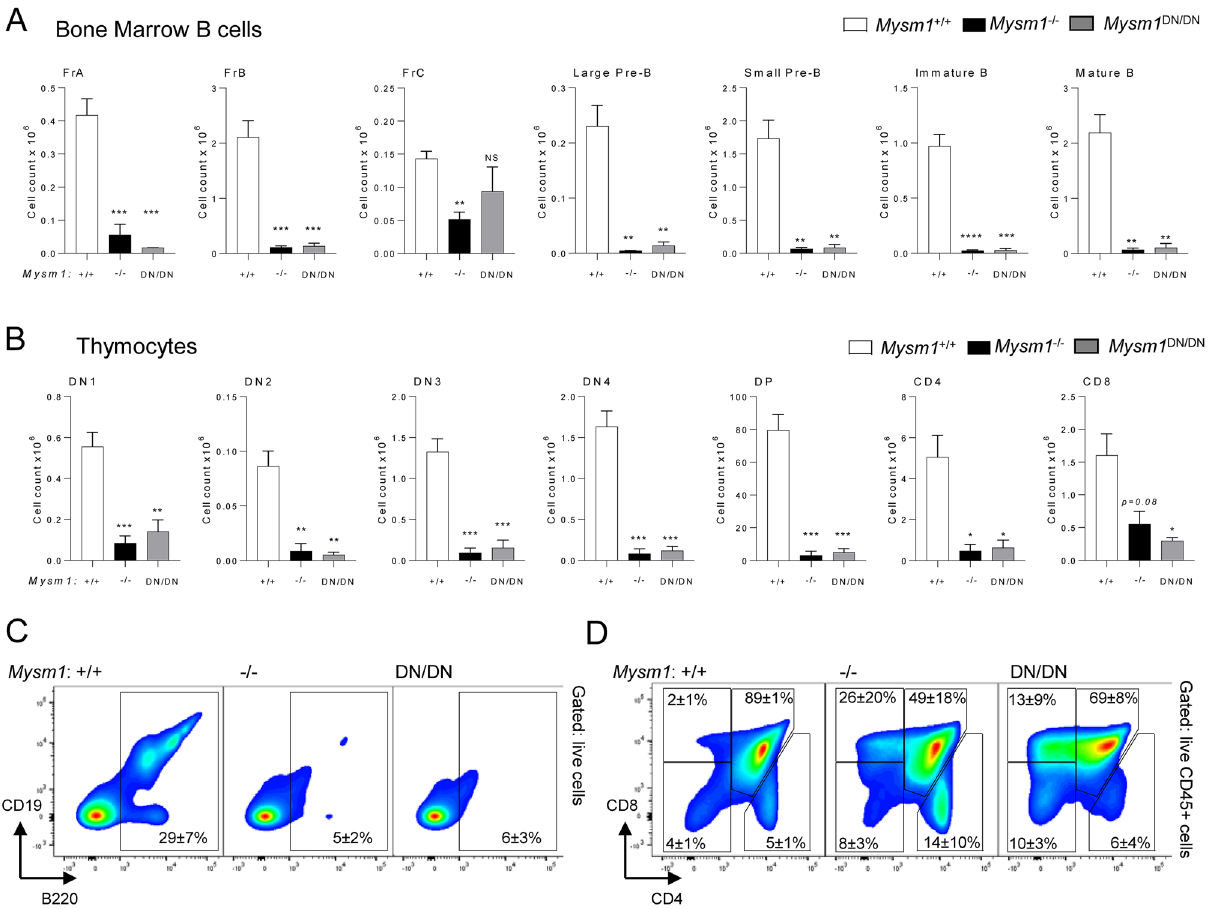
Figure 4. Depletion of B and T lymphocyte precursors in the bone marrow and thymus in mice with the loss of MYSM1 DUB catalytic activity. Flow cytometry analyses were performed on Mysm1 +/+ , Mysm1 −/− , and Mysm1 DN/DN mice, analyzing ( A ) the bone marrow for the following B cell populations: Fraction A (FrA,